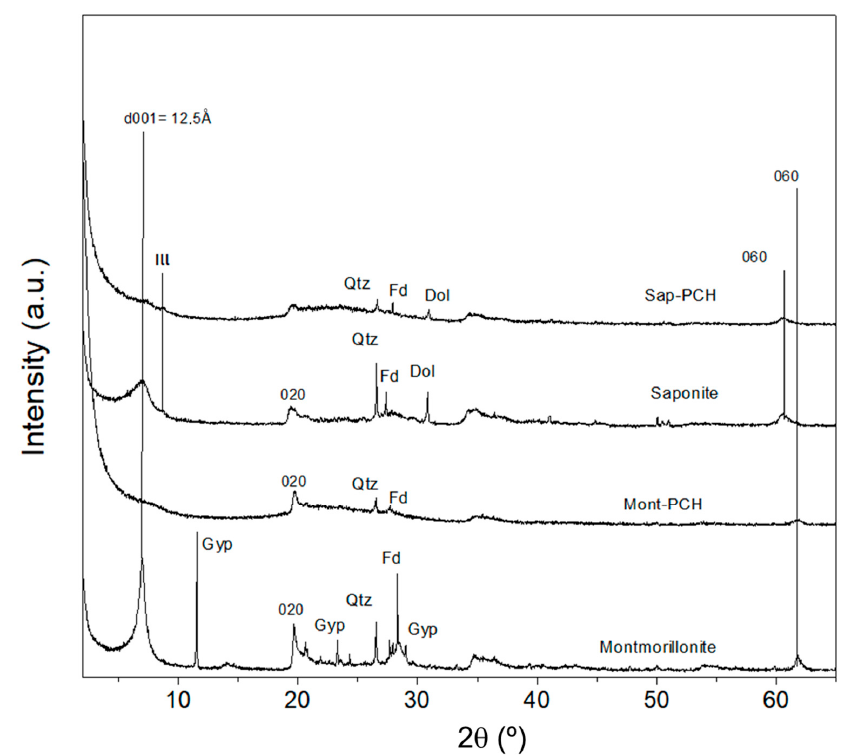
Figure 1. X-ray diffraction patterns of the raw montmorillonite, mont-porous clay heterostructure (PCH), raw saponite and sap-PCH. Acronyms: (Qtz: quartz, Fd: feldspar, Dol: dolomite, Gyp: gypsum).